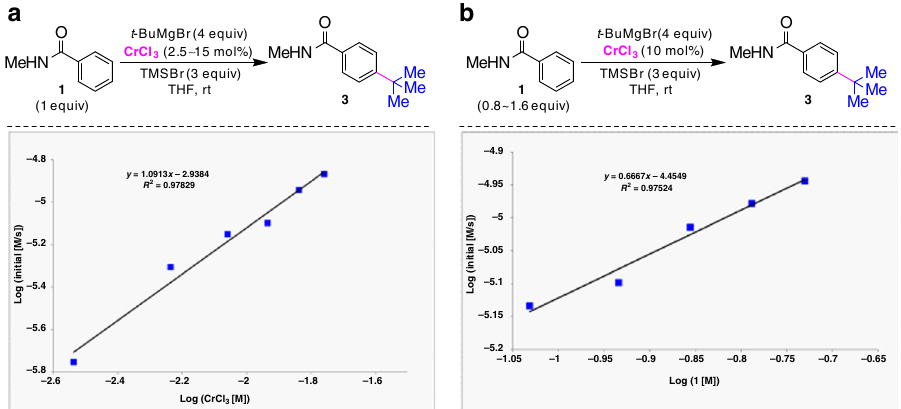
Fig. 6 Kinetic pro fi le for chromium-catalyzed para -alkylative reaction. a Plot of initial rate vs concentration of CrCl 3 reveal fi rst-order kinetics for chromium salt. b Plot of initial rate vs concentration of 1 indicates a slightly fi rst-order kinetics